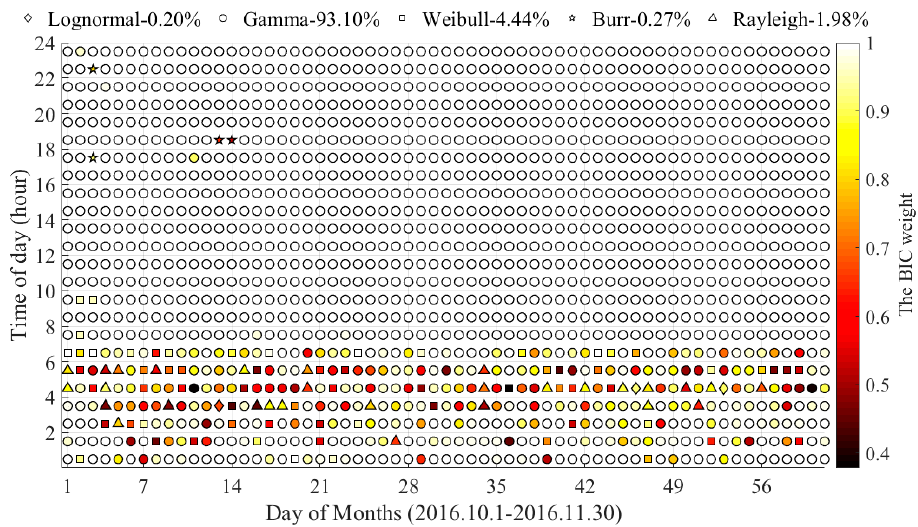
Figure 6. The fitting distributions of hourly travel distance.